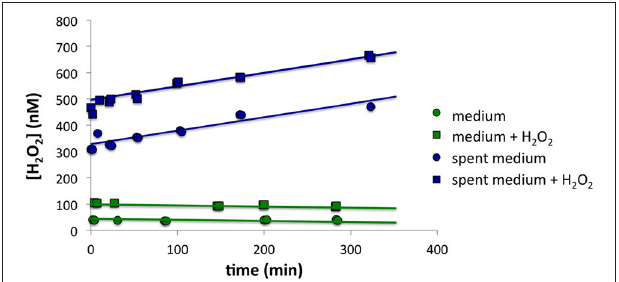
FIGURE 4 | Spiked batch incubations for (top) spent growth medium from P. tricornutum and (bottom) sterile F/2 medium. The circles indicate unaltered medium, while the squares indicate medium that has been spiked with additional H 2 O 2 .